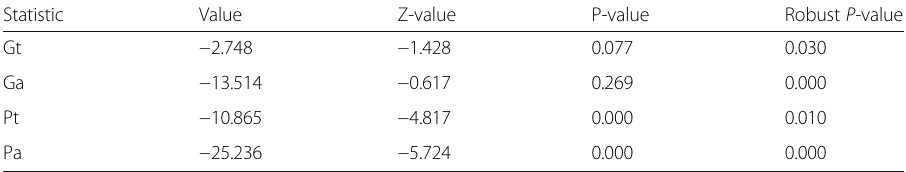
Table 8 Panel cointegration tests (Westerlund) Statistic Value Z-value P-value Robust P